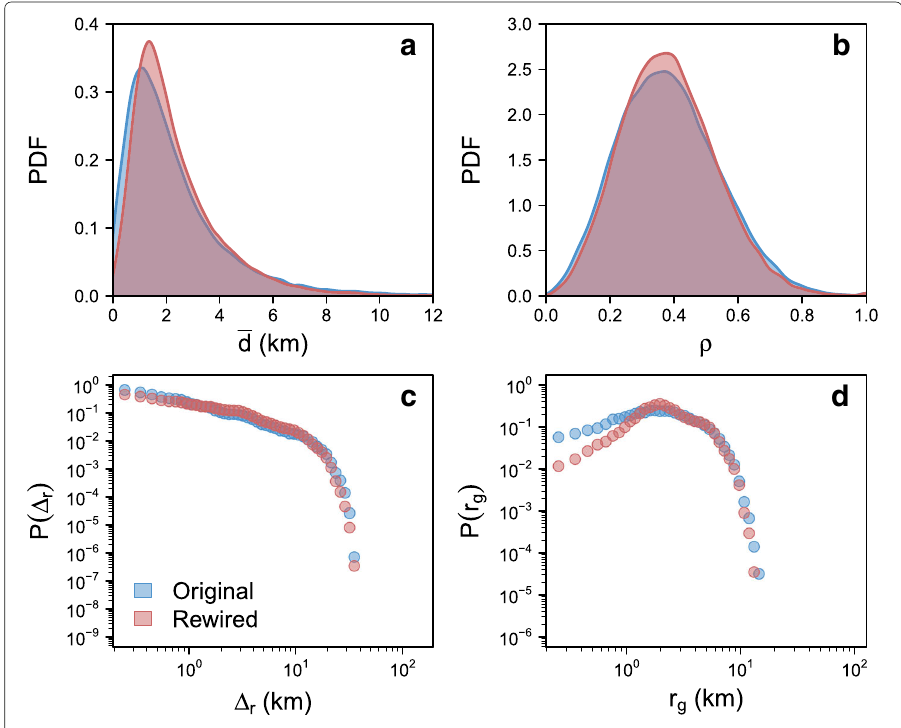
Fig. 3 Observed and simulated distributions of human mobility indicators. The distribution of jump lengths (cid:4) r ( c ), the radius of gyration r g ( d ), the tendency to return to already visited places ( average distance traveled ( ¯ d ) ( a ) are considered. Values measured on the empirical data are in blue , while those obtained after rewiring are in red . The calculation of (cid:4) r and r g is based on the business’ exact geographical coordinates. The simulated distributions plotted here correspond to one particular